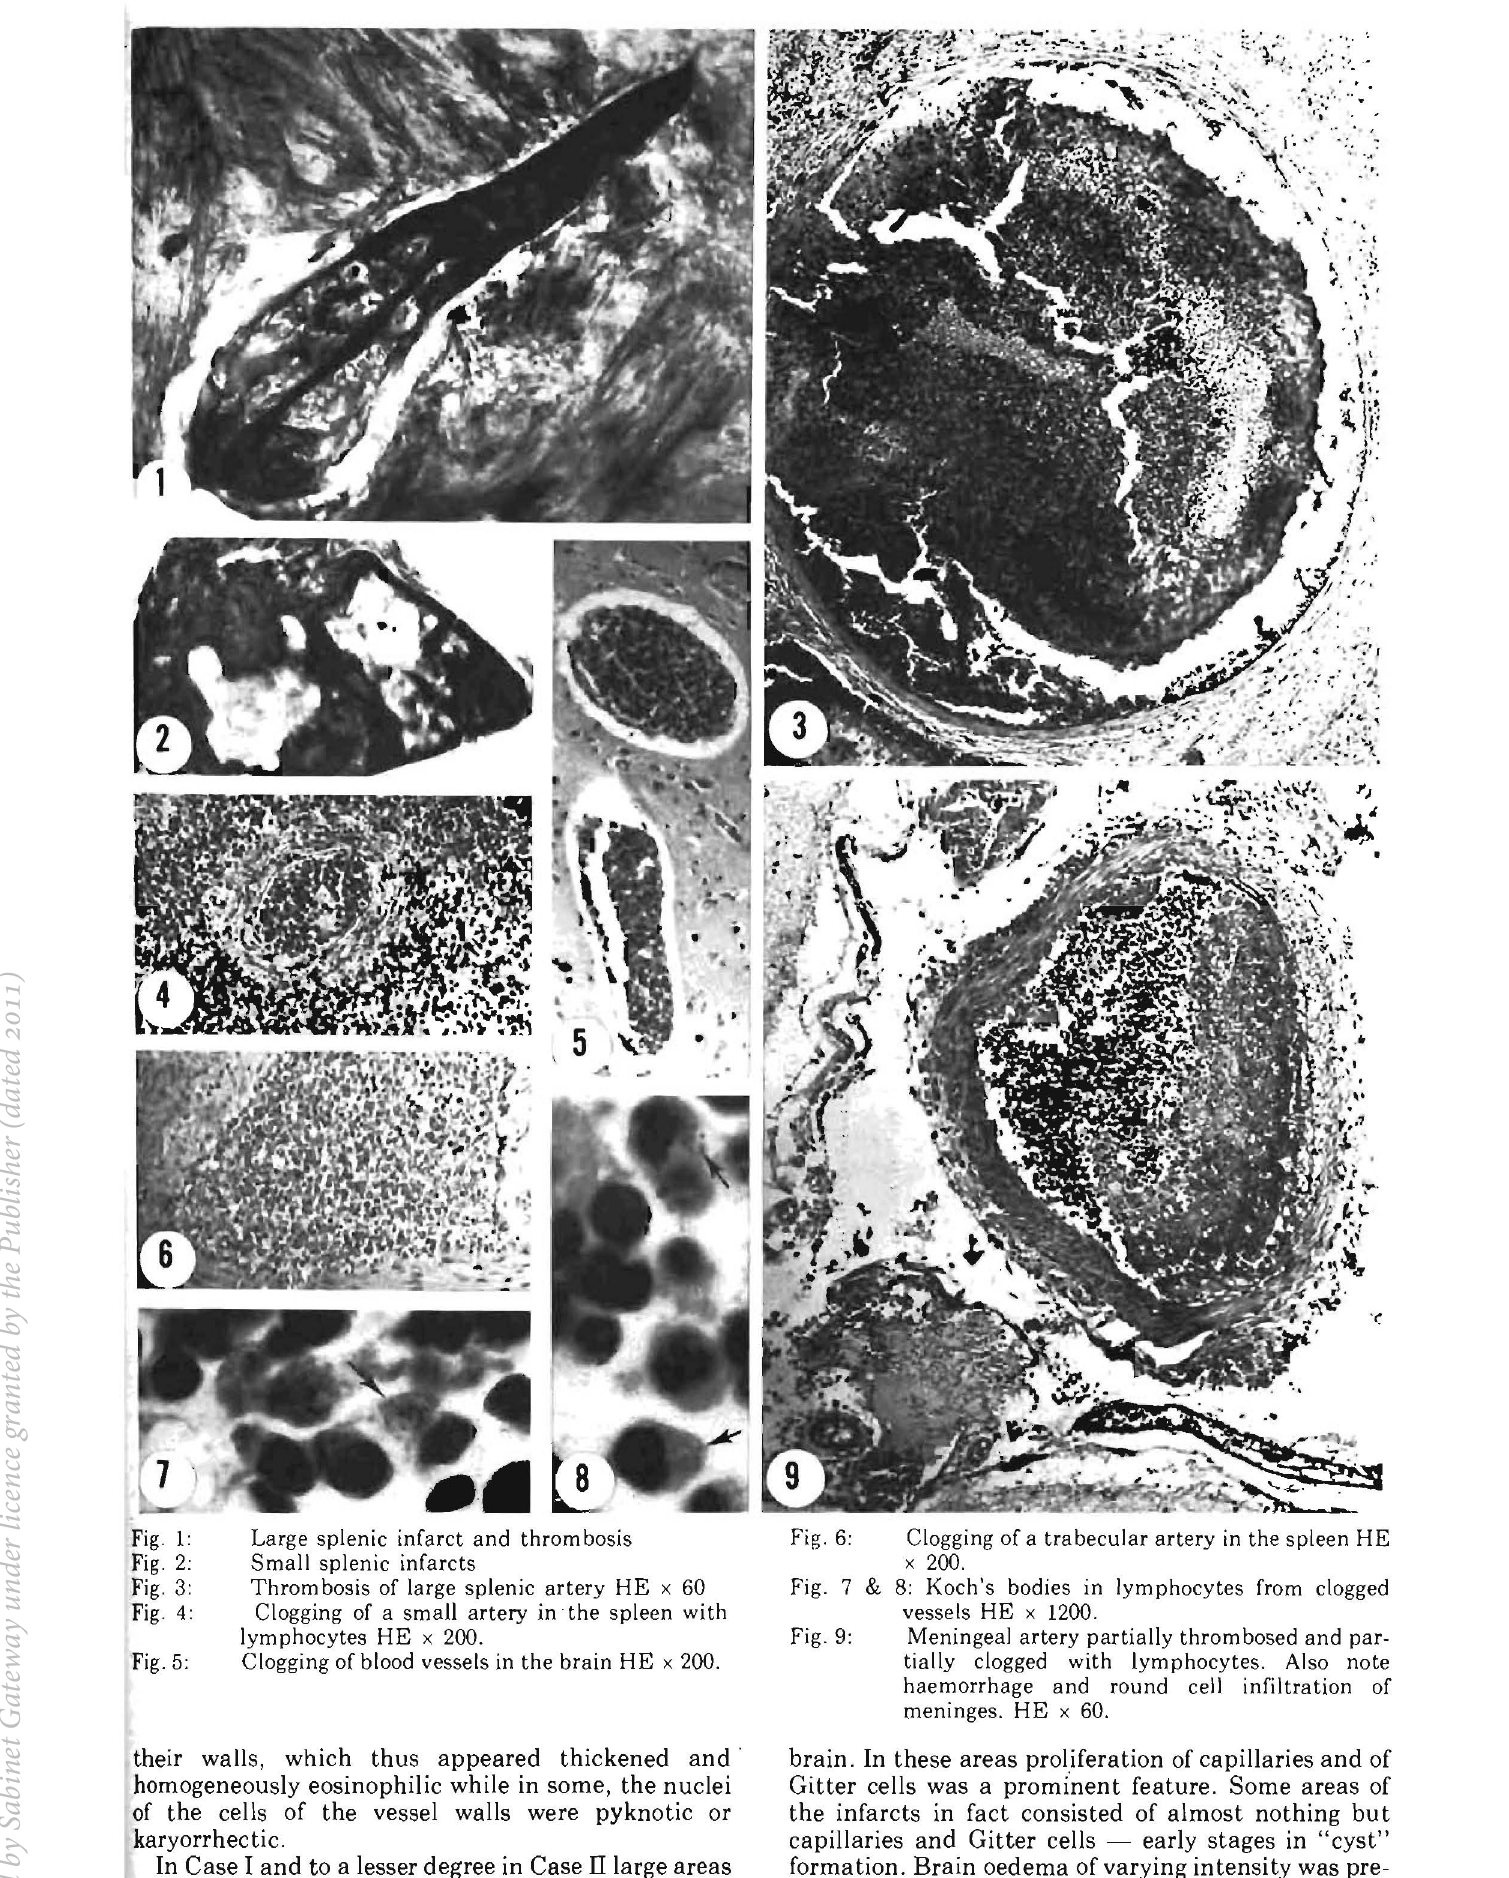
Fig. 1: Large splenic infarct and throm bosis Fig. 2: Small splenic infarcts Throm bosis of large splenic artery HE x 60 Fig. 3: Clogging of a small artery in the spleen with Fig. 4: lymphocytes HE x 200. Fig. 5: